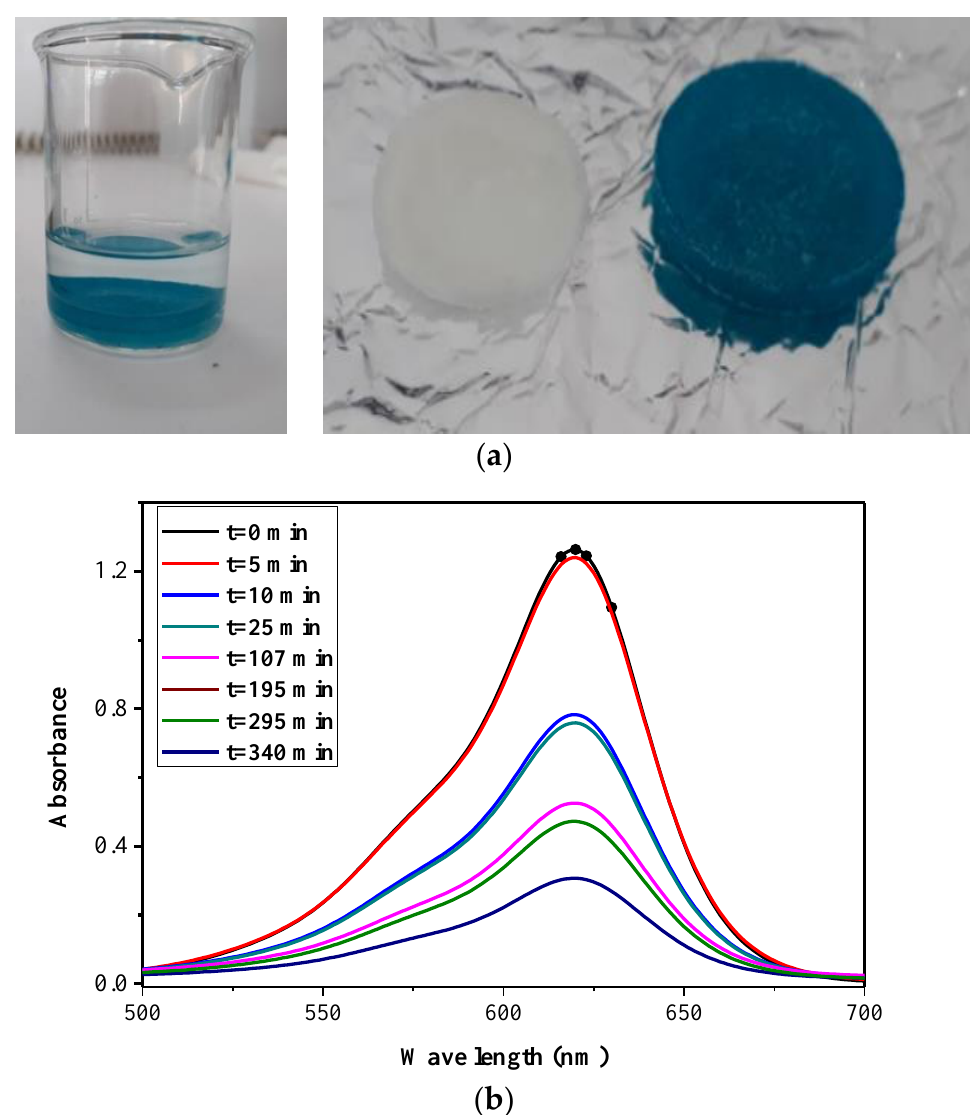
Figure 14. The malachite green solution and IPN hydrogel (before and after dye absorption) ( a ). Absorption kinetic of malachite green by IPN (cellulose–polyHEMA hydrogels) ( b ).